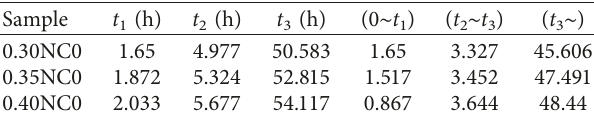
Figure 5: Effects of different NC dosages on the hydration process. Table 5: The hydration period separation time of cement pastes with different NC